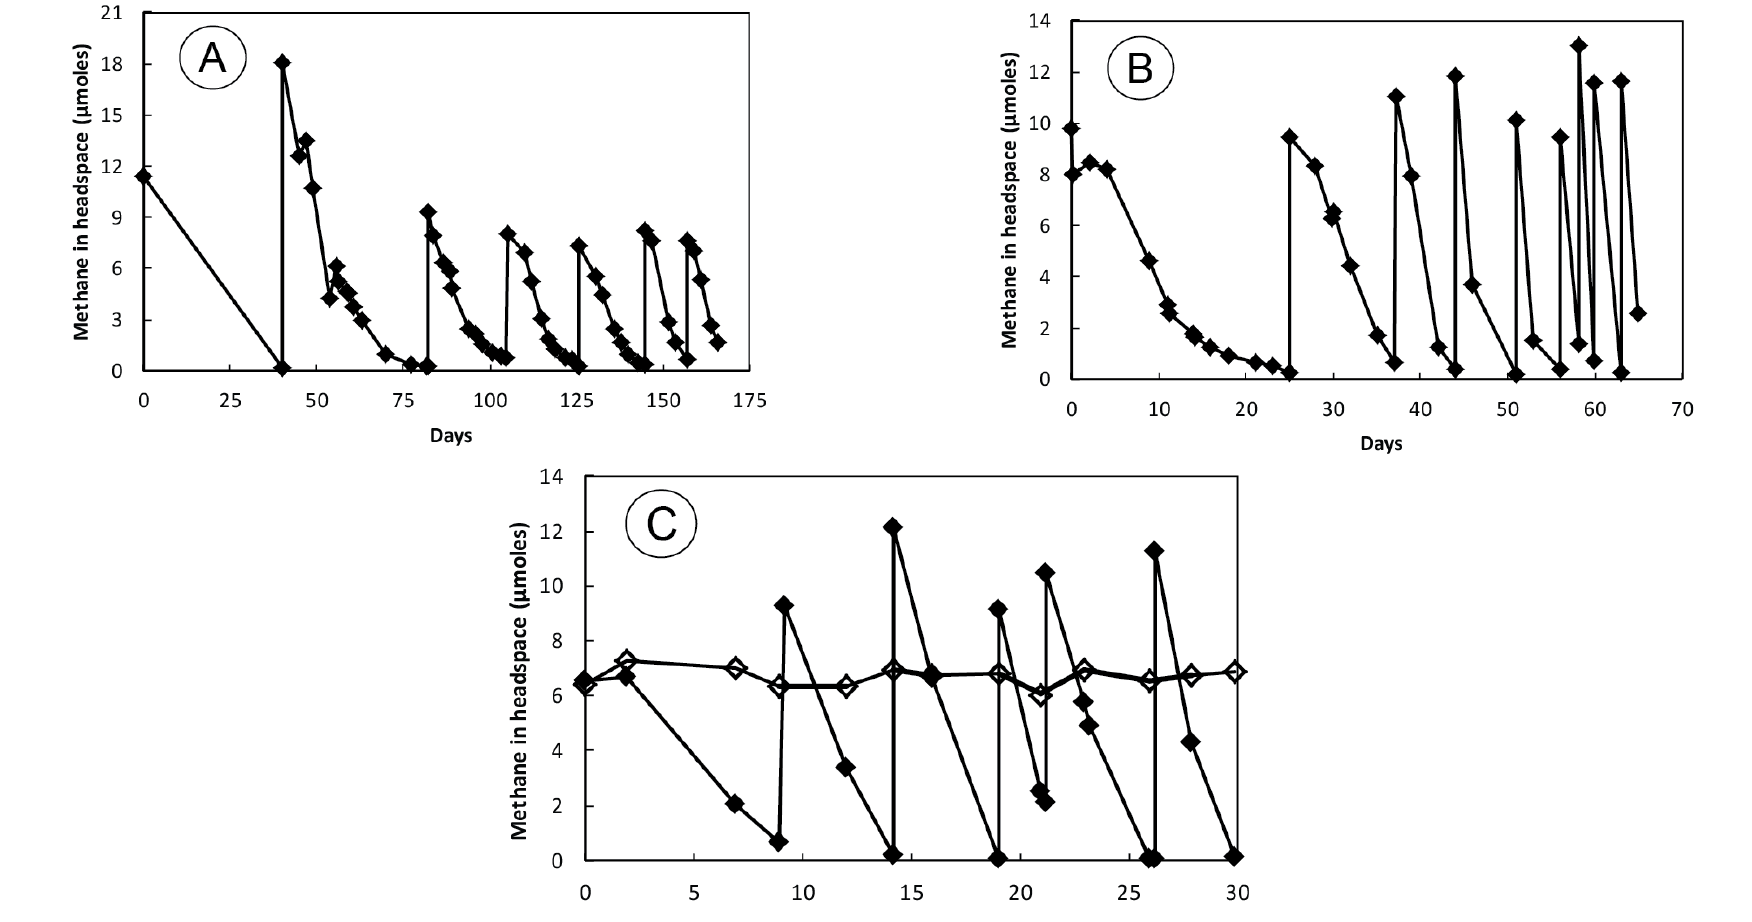
Figure 1. Methane oxidation by unshaken sediment slurries generated from the Herman Pit. ( A ) Initial incubation in lake water from which an aliquot was transferred into an artificial medium ( B ). ( C ) Consumption of methane in Balch tubes incubated with aliquots from the previous incubation ( B ) in a serum bottle. Open diamonds indicate enrichment incubated under air while closed diamonds indicate an enrichment incubated under 40% O 2